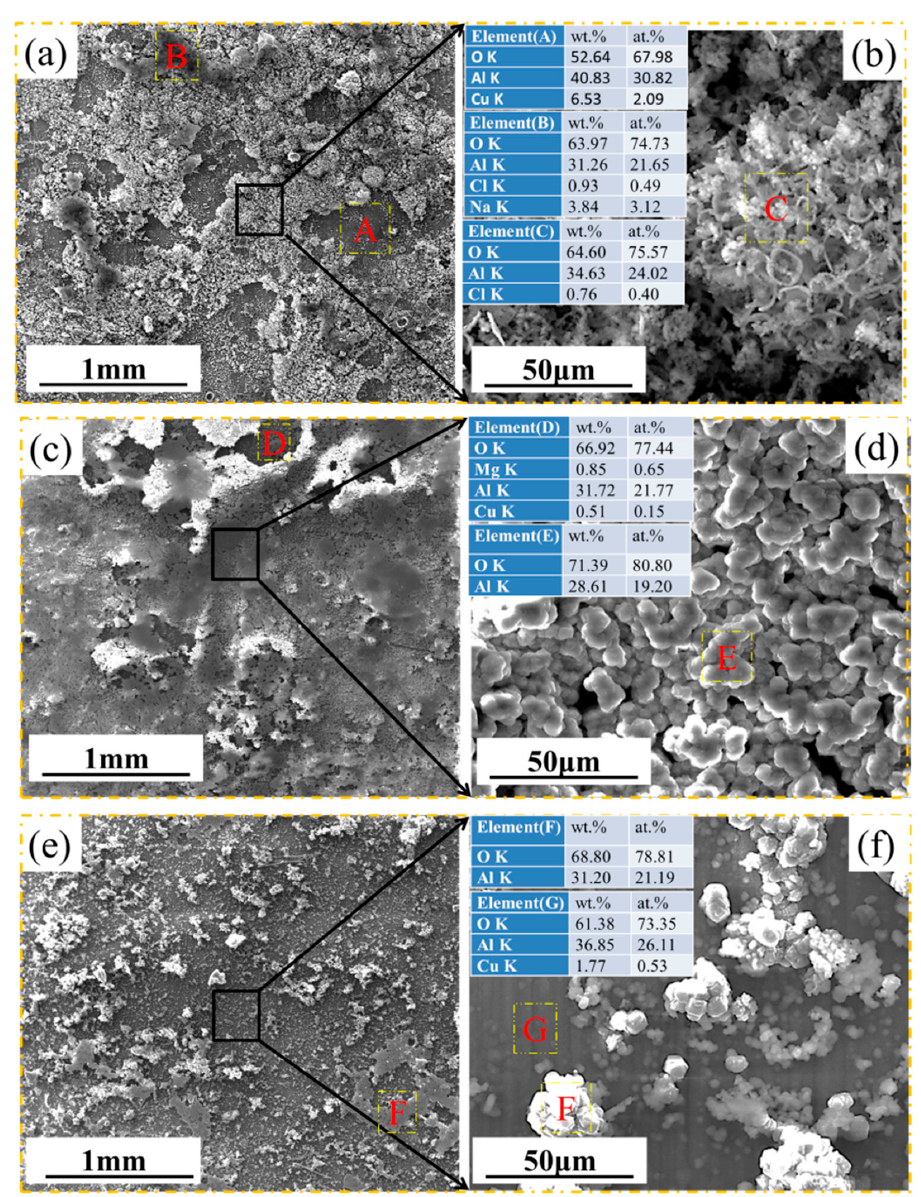
Figure 5. SEM images of microscopic surface morphology of the samples after corrosion 200 h under 4 ± 0.2 mg/cm 2 solid NaCl deposit in 98 ± 2% humidity: ( a , b ) at 30 °C; ( c , d ) at 60 °C; and ( e , f ) at 80 4 ± 0.2 mg/cm 2 solid NaCl deposit in 98 ± 2% humidity: ( a , b ) at 30 ◦ C; ( c , d ) at 60 ◦ C; and ( e , f ) °C. EDS results for A-G locations were also presented.